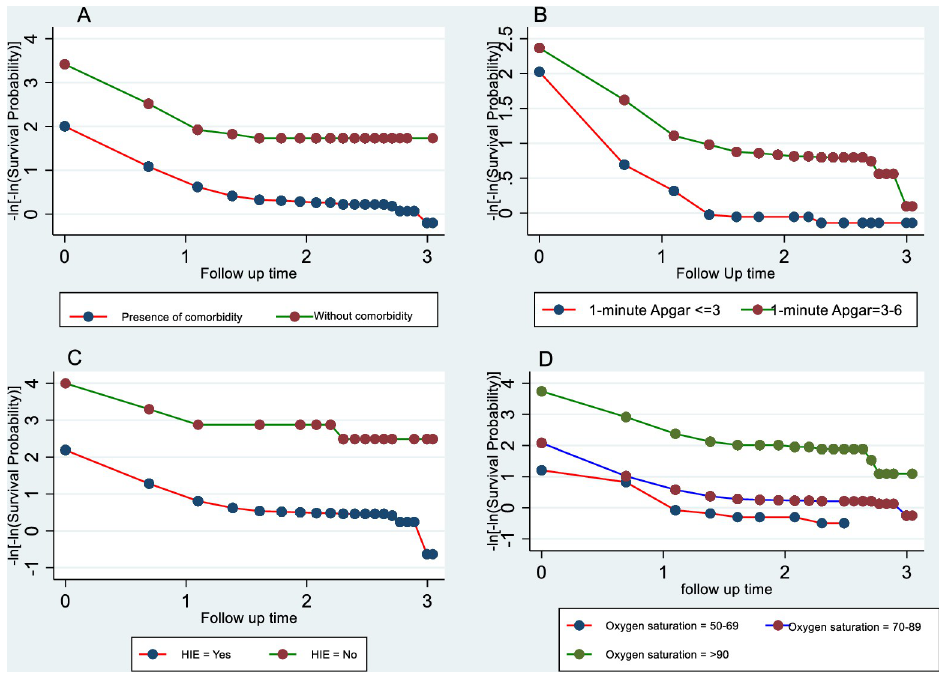
Fig 1. Plot of log (-log (survival probability)) Vs log (analysis time) by comorbidity (A), 1-minute Apgar score (B), Hypoxic Ischemic Encephalopathy (HIE) (C), and level of Oxygen saturation (D).